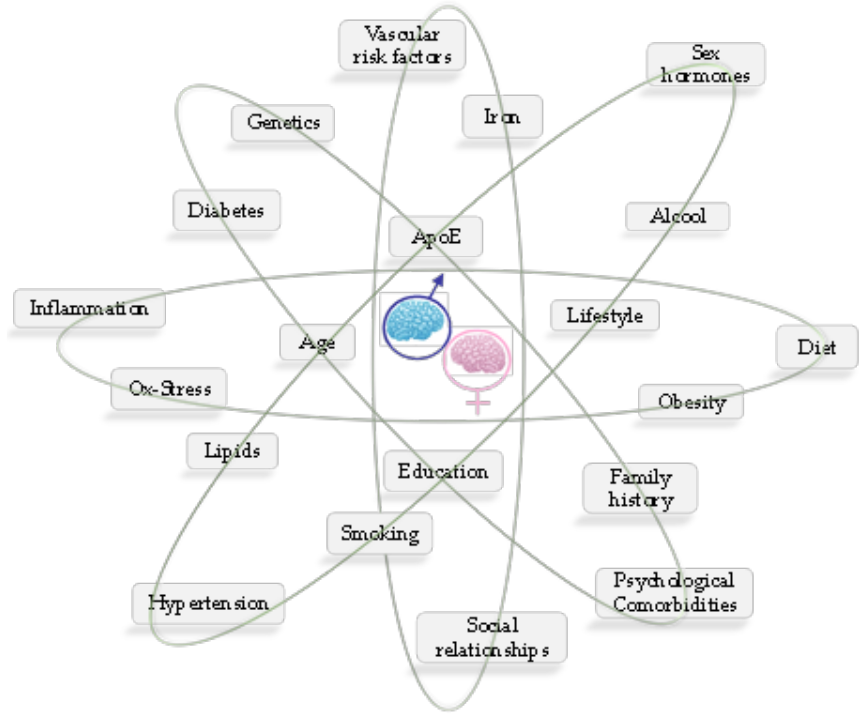
Figure 5. Snapshot of key risk factors for the development of AD and other types of dementia.